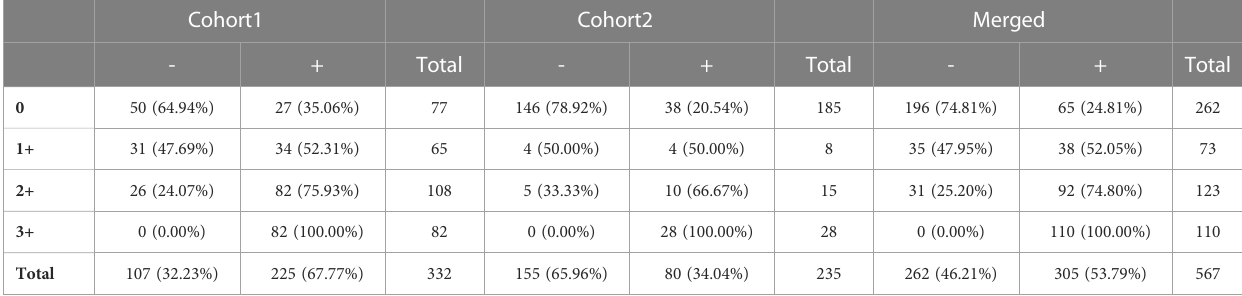
TABLE 3 Evaluation of the distribution of breast cancer specimens with no Her2 expression (Her2-0) from those with any Her2 expression (Her2-E) in each IHC category based on the limit of detection (LOD) of the QDB method using 4B5 antibodies.